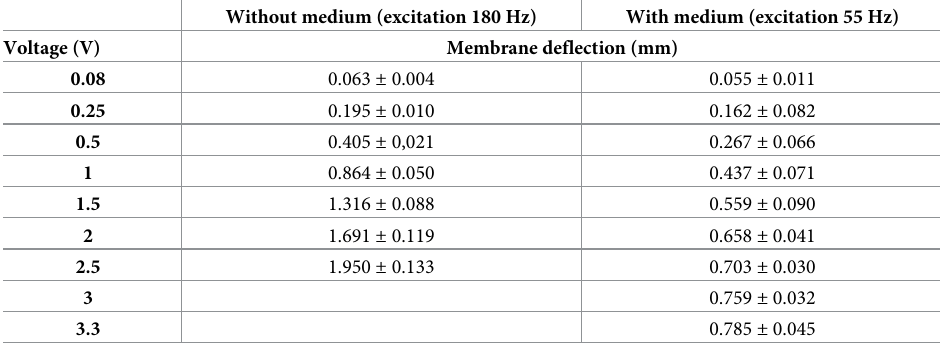
Table 2. Membrane deflections at different audio output